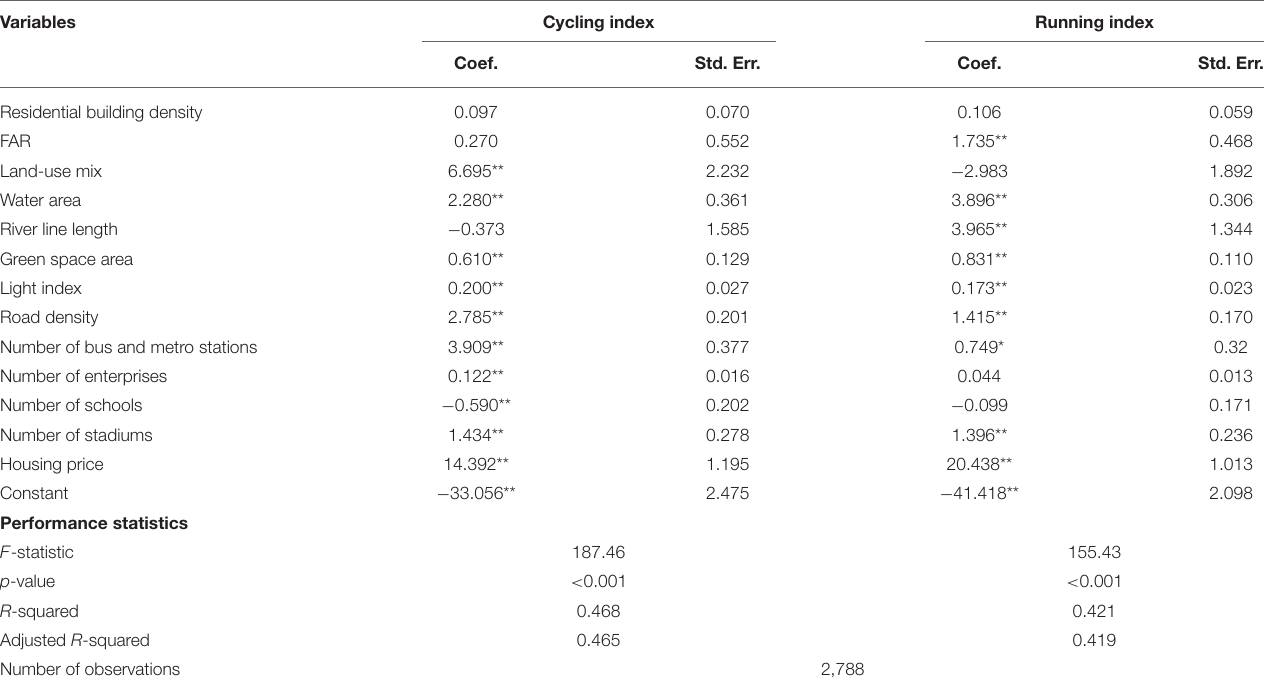
TABLE 2 | OLS modeling